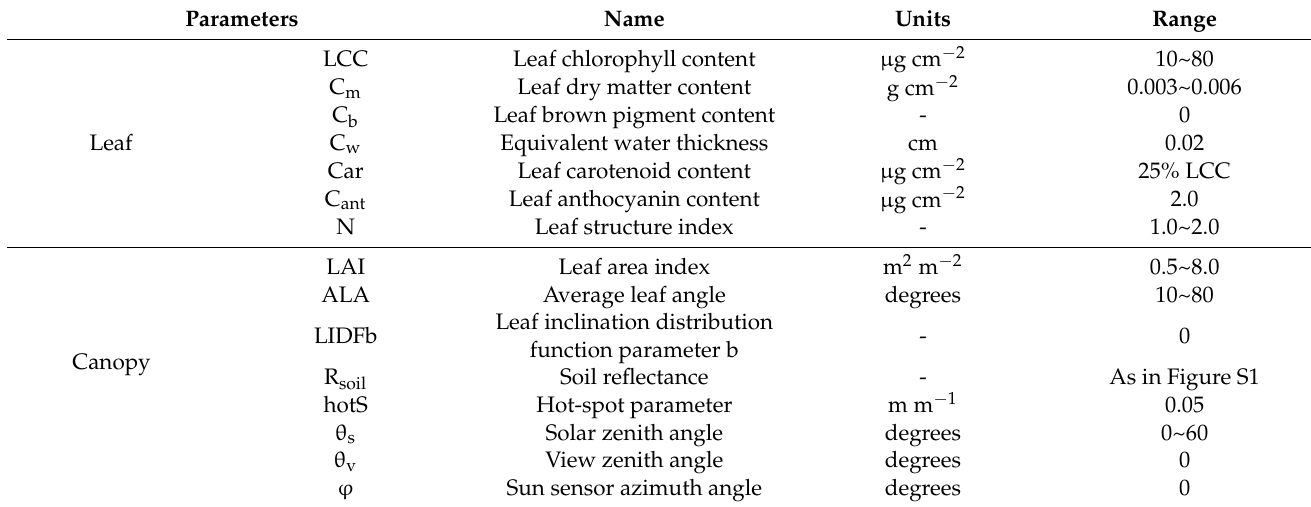
Table 2. Configuration of the input parameters for the PROSAIL-D model